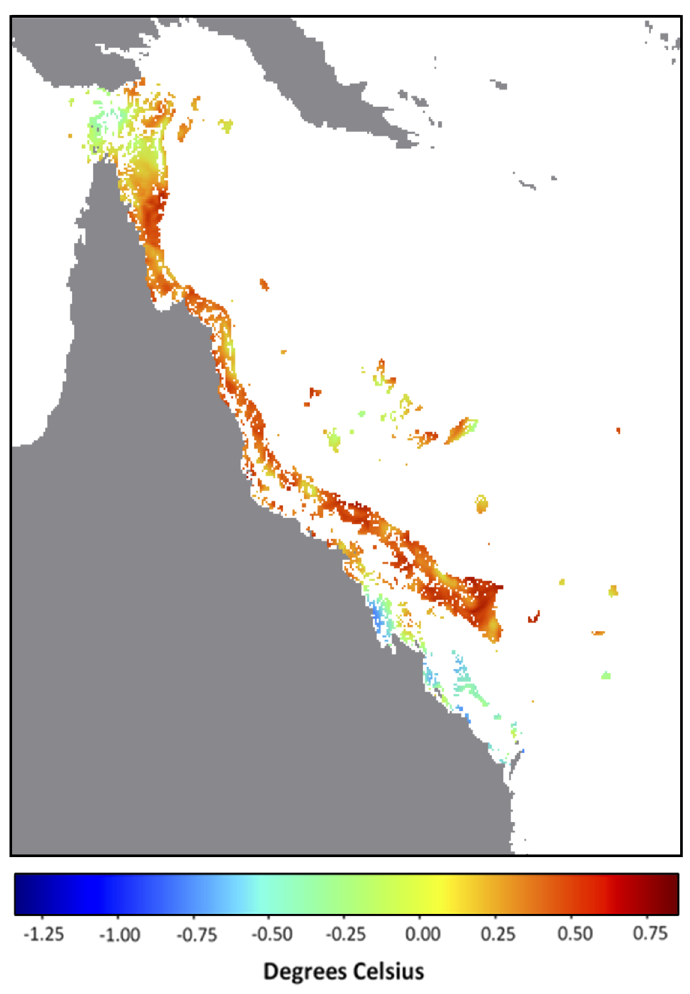
Figure 1. December 2021 Background temperature compared with November – December all-time maximum temperature. Map of Great Barrier Reef 5 km-resolution satellite pixels (0.05 ° (cid:1) 0.05 ° ) denoting the difference between the background temperature for 14 December 2021 (minimum SST observed over the previous 29 days, 16 November - 14 December) and the all-time (1985-2020) maximum temperature between 16 November and 14 December. Values indicate difference in degrees Celsius; positive values and warm colours indicate reef pixels in which the 2021 background temperature is higher than the all-time